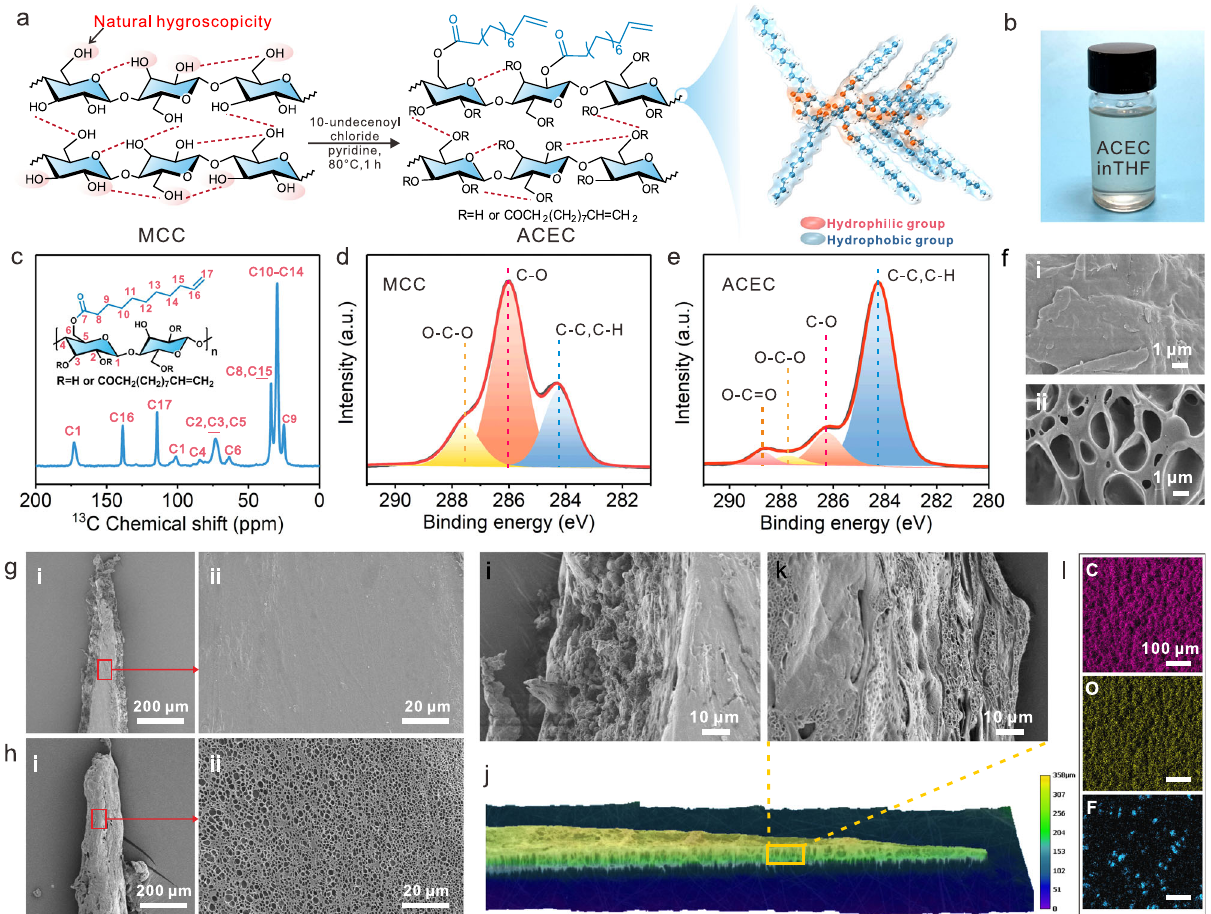
Fig. 2 Preparation and characterization of ACEC. a , b Reaction scheme of ACEC and photo of ACEC dissolved in THF. c Solid-state 13 C NMR spectra of ACEC. d , e High-resolution C1s XPS spectra of MCC and ACEC. f SEM images of MCC and ACEC. g , h SEM images of FEP spines and ACEC@FEP spines. i SEM image of the side of the FEP spine. J , k 3D image of the complete ACEC@FEP spine structure and SEM image of its side. l EDX-mapping images of C, O, and F elements of